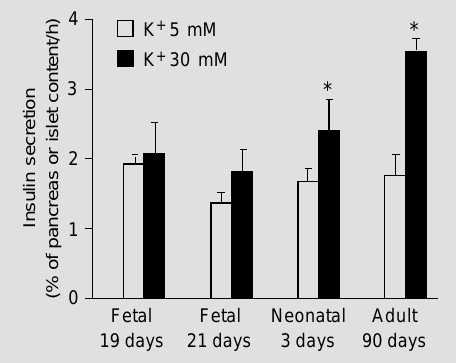
Figure 2 - Effect of 30 mM K + on insulin secretion. Fragments of fetal or neonatal pancreas or adult rat islets were preincu- bated for 45 min at 37 o C in a Krebs-bicarbonate medium con- taining 5.6 mM glucose. This medium was then replaced with Krebs-bicarbonate containing 30 mM K + . The osmolarity of the medium was kept constant by withdrawing an equimolar amount of NaCl. The columns represent the cumulative (1 h) insulin secretion, expressed as percentage of the total fragment or islet content, at each K + con- centration. Values are reported as the mean ± SEM of 6-9 ex- periments. *P<0.05 compared to insulin secretion with 5 mM K +